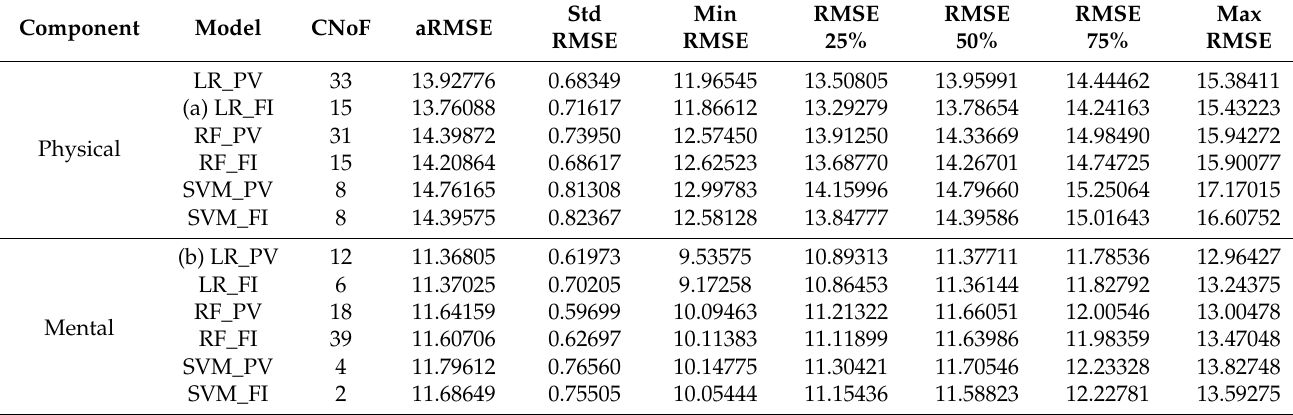
Figure 3. Average root mean square error (aRMSE) based on the cumulative number of features (CNoF) of the six categorized models. The y-axis indicates the aRMSE of the model; the x-axis indicates the level of the CNoF sorted by the ranking of feature selection methods. Each line graph indicates one of the six categorized models that is identical to the legend. LR_PV, multiple linear regression (LR) model with feature rank based on p -value (PV); LR_FI, multiple LR model with feature rank based on feature importance (FI); RF_PV, random forest (RF) regression with feature rank based on PV; RF_FI, RF regression with feature rank based on FI; SVM_PV, support vector machine (SVM) regression of radial basis function kernel with feature rank based on PV; SVM_PV, SVM regression of radial basis function kernel with feature rank based on FI. Table 1. Statistics of the generated models which minimizes the average root mean square error (aRMSE) in both physical component and mental